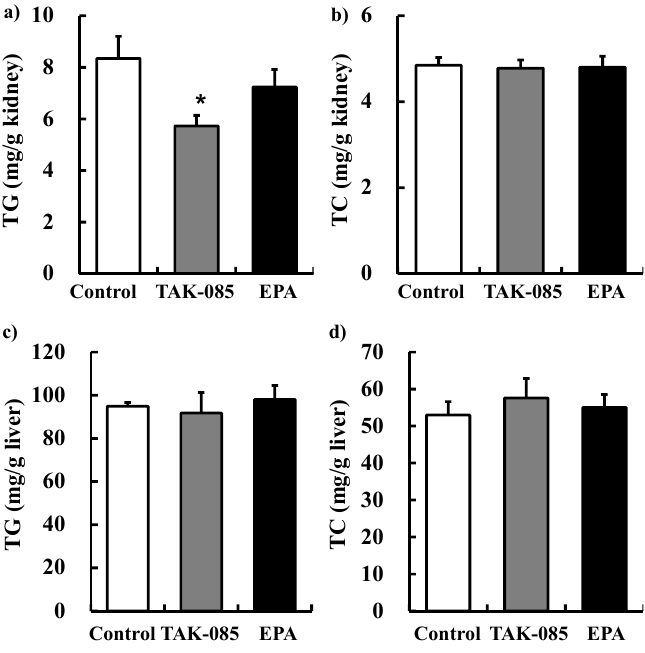
Figure 2. Effects of TAK-085 and EPA on lipid levels in the kidney and liver. TG ( a ) and TC ( b ) levels in the kidney. TG ( c ) and TC ( d ) levels in the liver. Values are presented as mean ± SE (n = 10–11). Statistical analysis was performed by one-way ANOVA followed by Dunnett’s test. * P < 0.05 vs. control